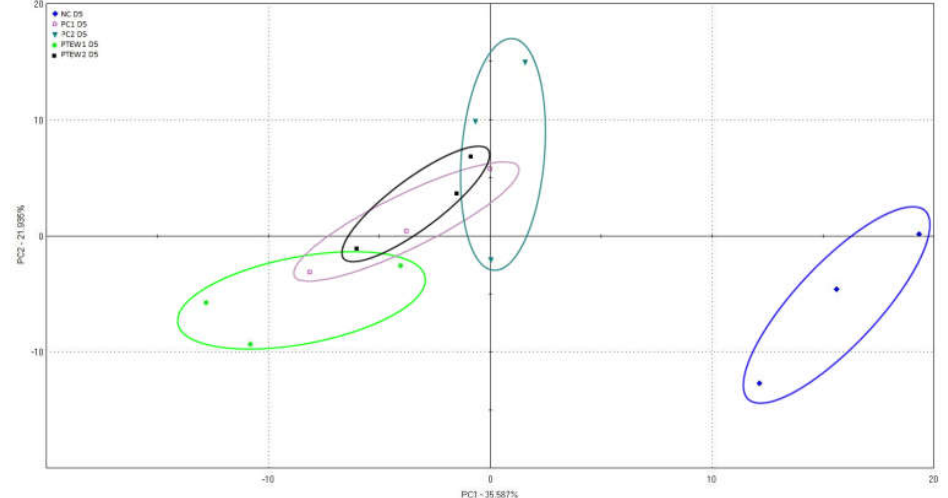
Figure 5. Principal component analysis of liver pâtés—day 5; NC—negative control (liver pâtés without nitrite source); PC1—positive control (liver pâtés with 60 ppm of sodium nitrite); PTEW1— liver pâtés with plasma-treated egg white containing 40 NO 2− ; PC2—(liver pâtés with 120 ppm of sodium nitrite); PTEW2—liver pâtés with plasma-treated egg white containing 80 NO 2− .